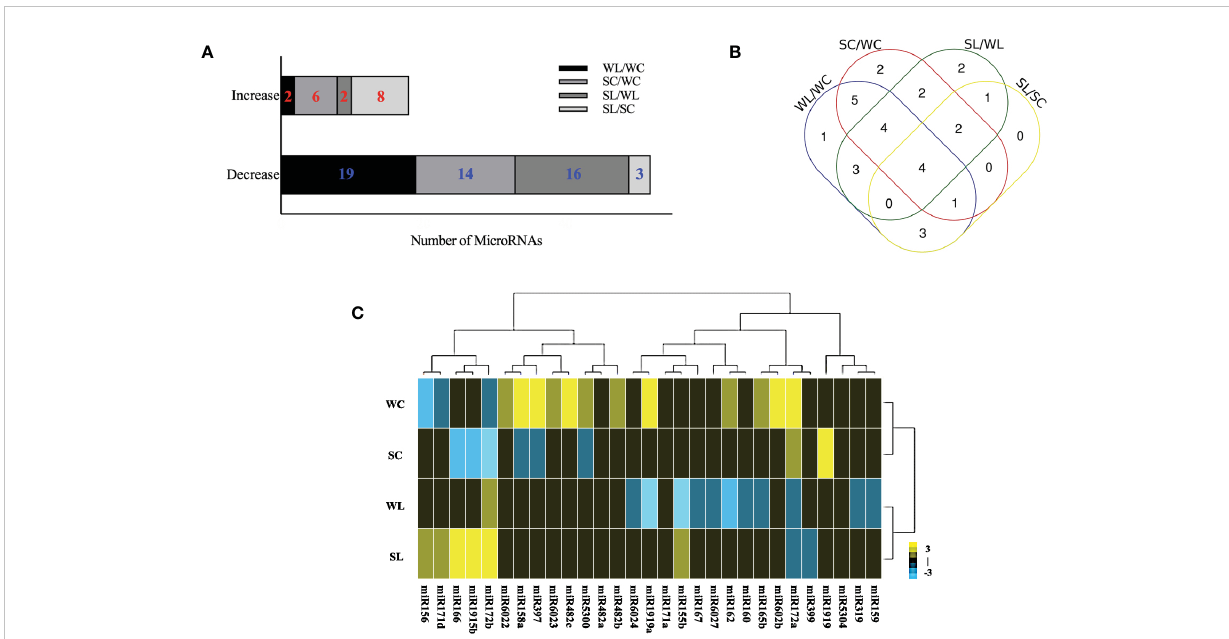
FIGURE 2 SRNA-seq pro fi ing of differentially expressed mRNAS under LNT stress in tomato. (A) Diferential expression of conserved miRNAs in four libraries (WC, wild-type tomato plants under normal conditions; WL, wild-ype tomato plants under LNT stress; SC, sit tomato mutans under normal condilons; SL, sit tomato mutans under LNT stress). Data are means and standard error of four independent experiments (n = 4). Signi fi cant differences compared with each group was determined using P < 0.05. (B) Venn diagram of signi fi cantly different miRNAS in the four groups. (C) Clustering of di fl ferentially expressed miRNAs. Yellow indicates high expression, while blue indicates low expression. The consecutive fold change was set from -3 to